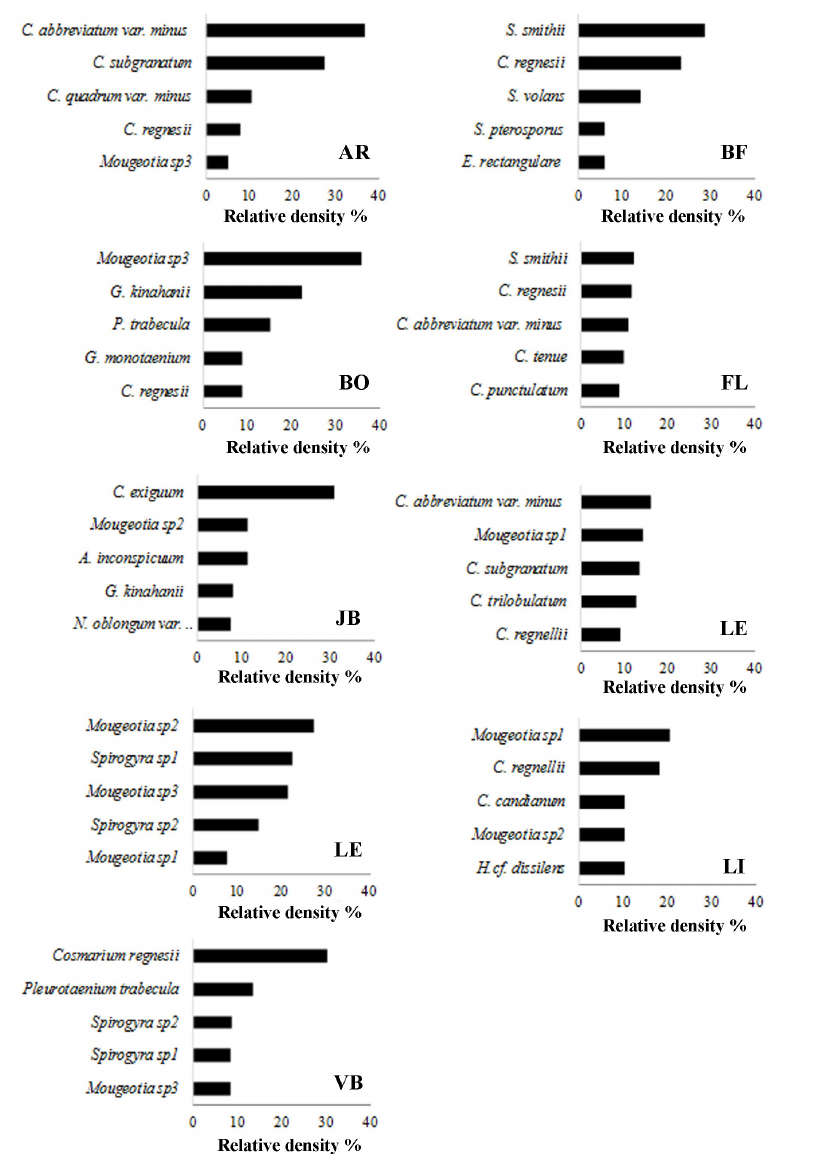
Figure 5. Relative density (%) of the five most abundant taxa among periphytic Zygnematophyceae in nine urban eutrophic ponds from Goiânia, GO (see codes at Table